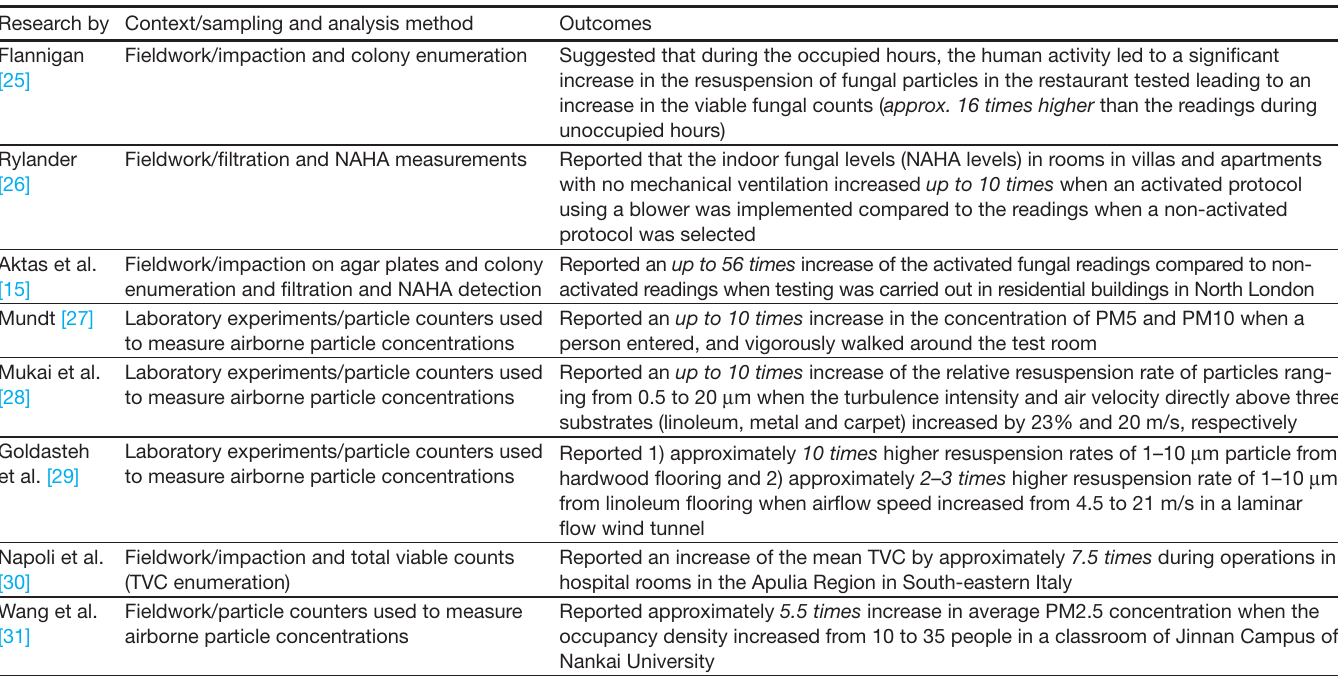
Table 2. Effect of the activation to the particle resuspension and fungal readings reported in the